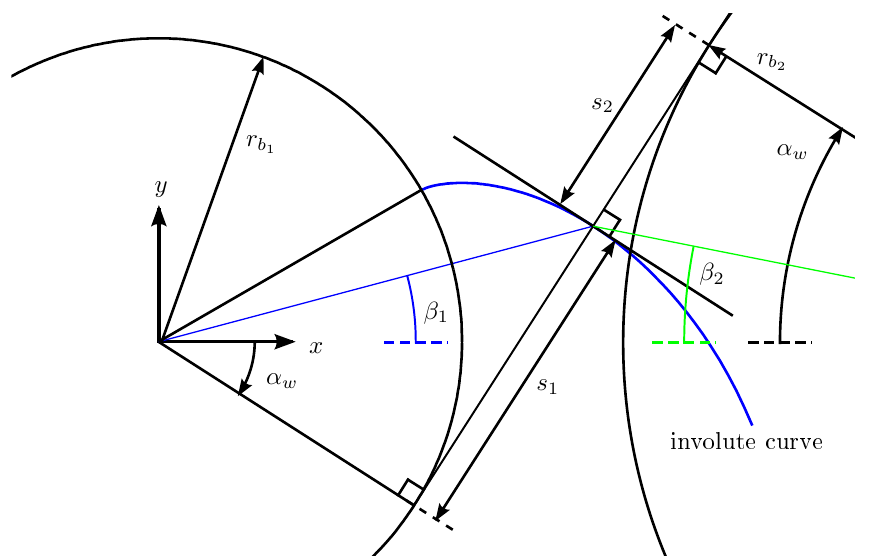
Figure 6: Base circle arc length, s 1 and s 2 with involute curve shown on gear 1. The load from gear 2 acts along the line of action. Base circle radii are denoted r b and working pressure angle is α w . Angle from center to contact points are denoted β